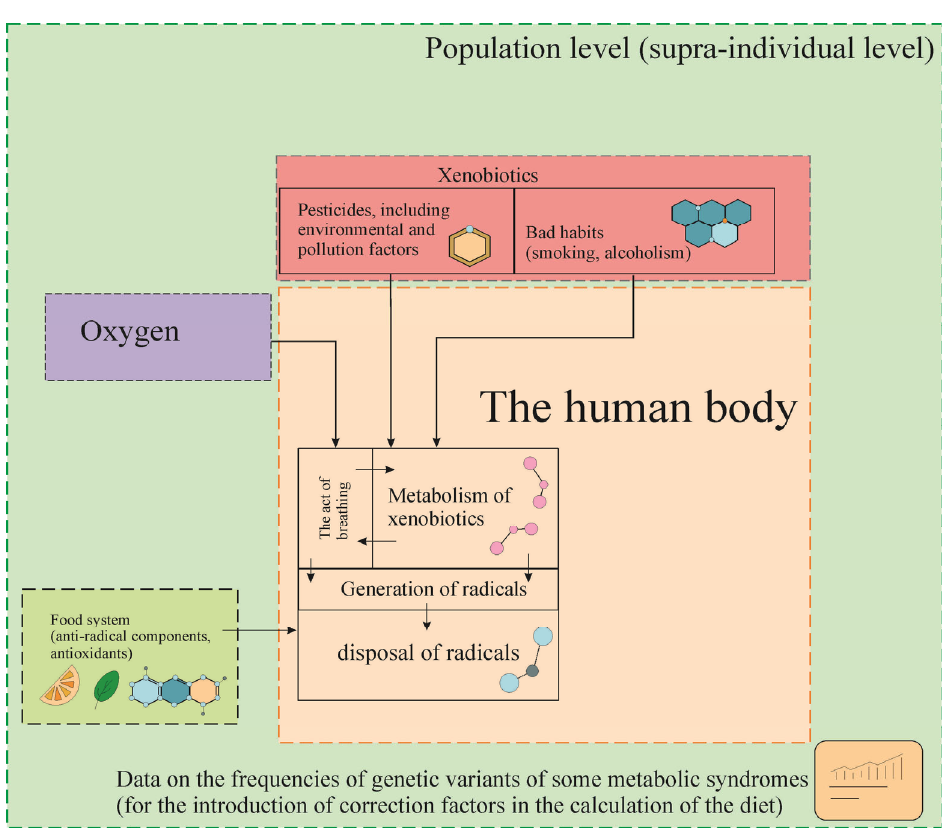
Figure 1. A diagram illustrating the stages of research to calculate the volume of production of free radicals and food components capable of reacting with them.